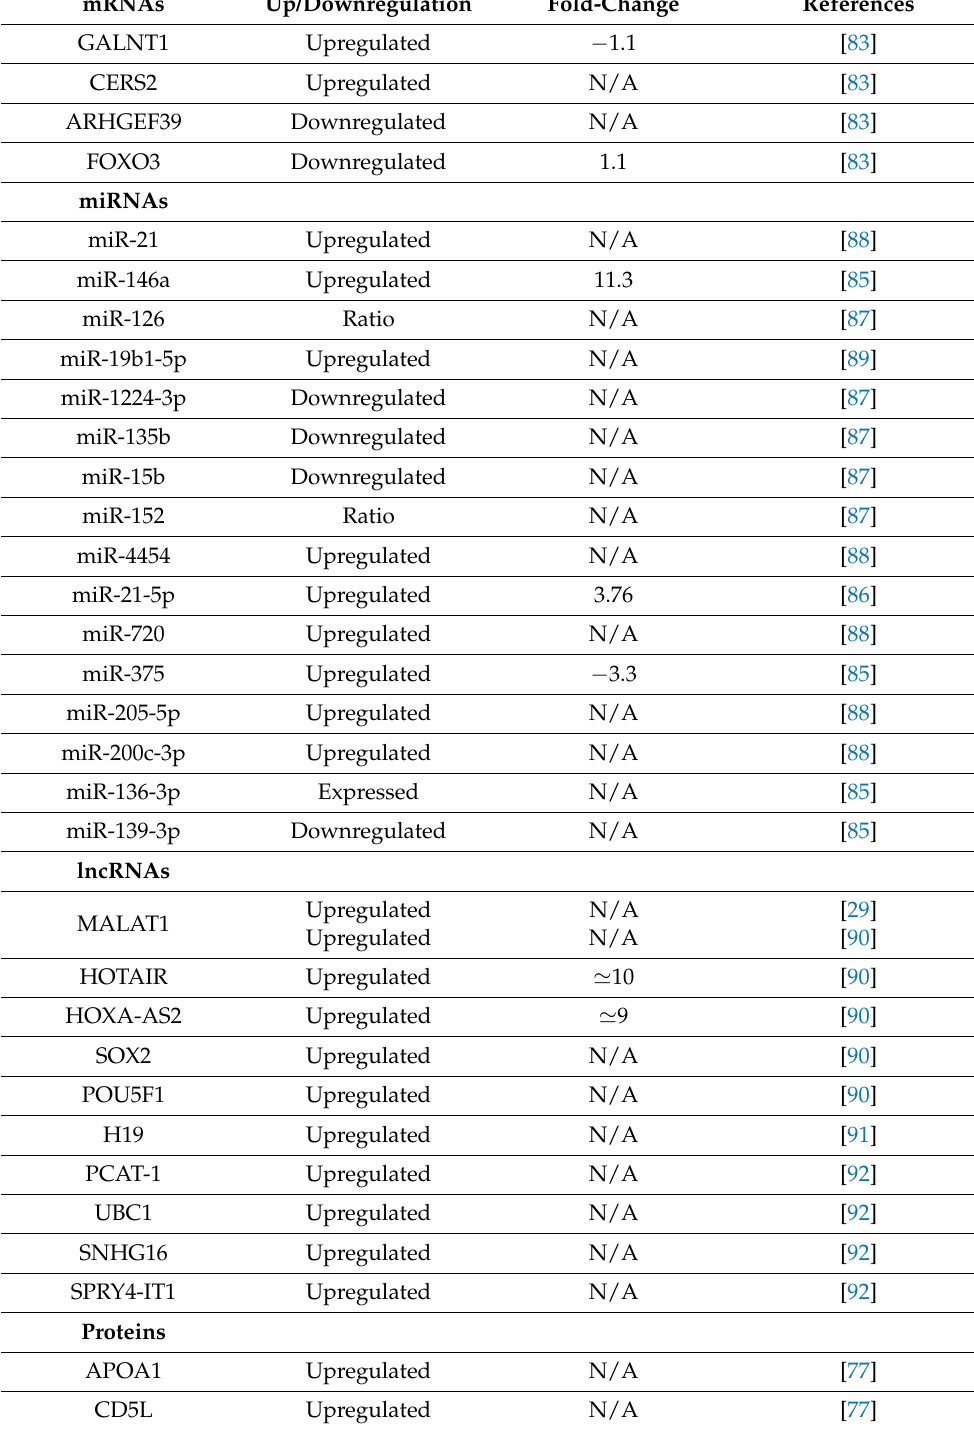
Table 4. EV-associated biomarkers used for bladder cancer